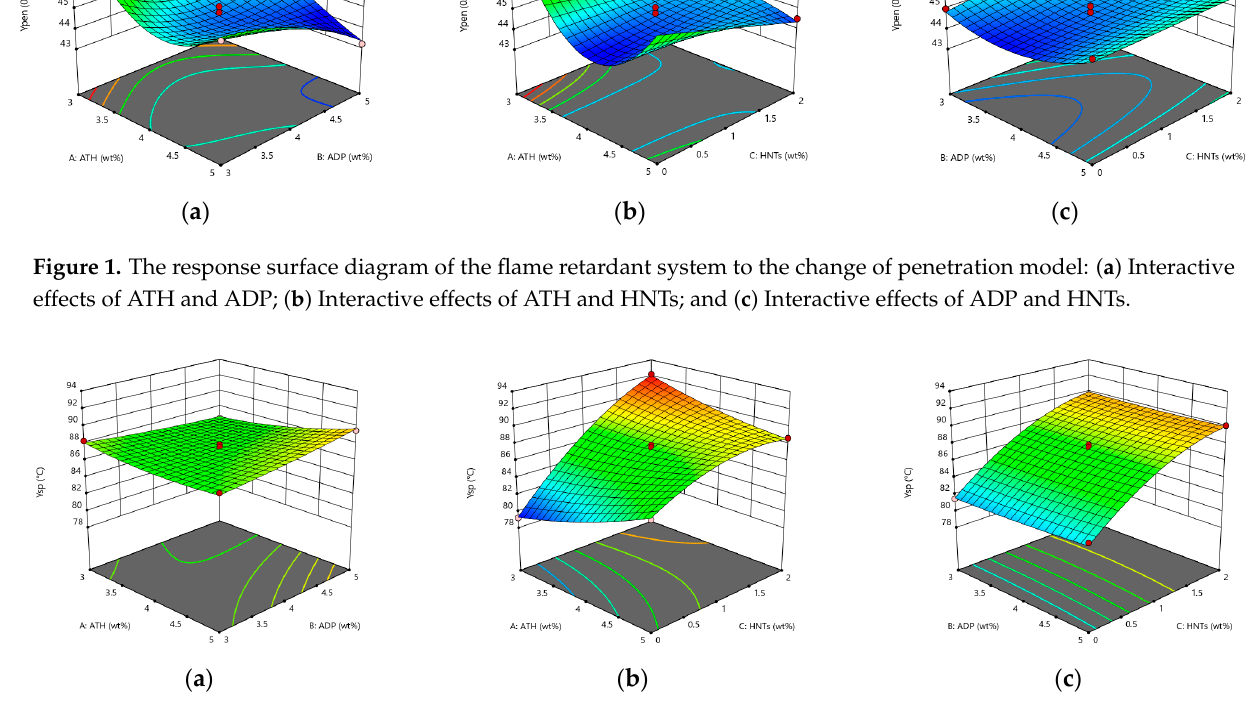
Figure 2. The response surface diagram of the flame retardant system to the change of softening point model: ( a ) Interactive effects of ATH and ADP; ( b ) Interactive effects of ATH and HNTs; and ( c ) Interactive effects of ADP and HNTs.